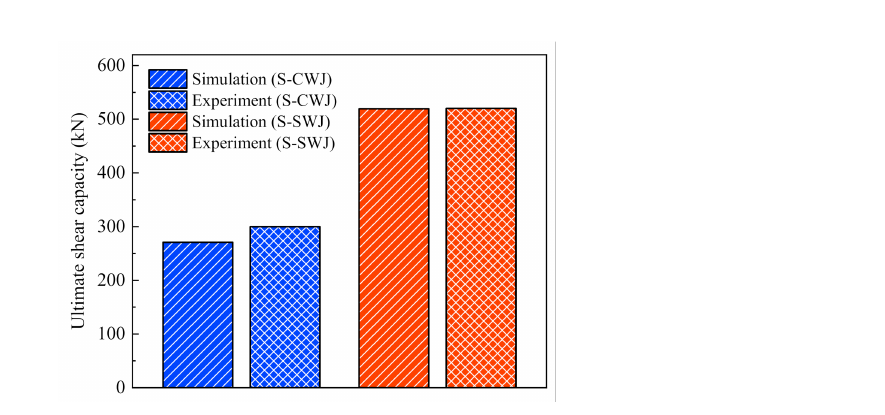
Figure 8. Comparison between numerical and experimental results for both S-CWJ and S-SWJ.